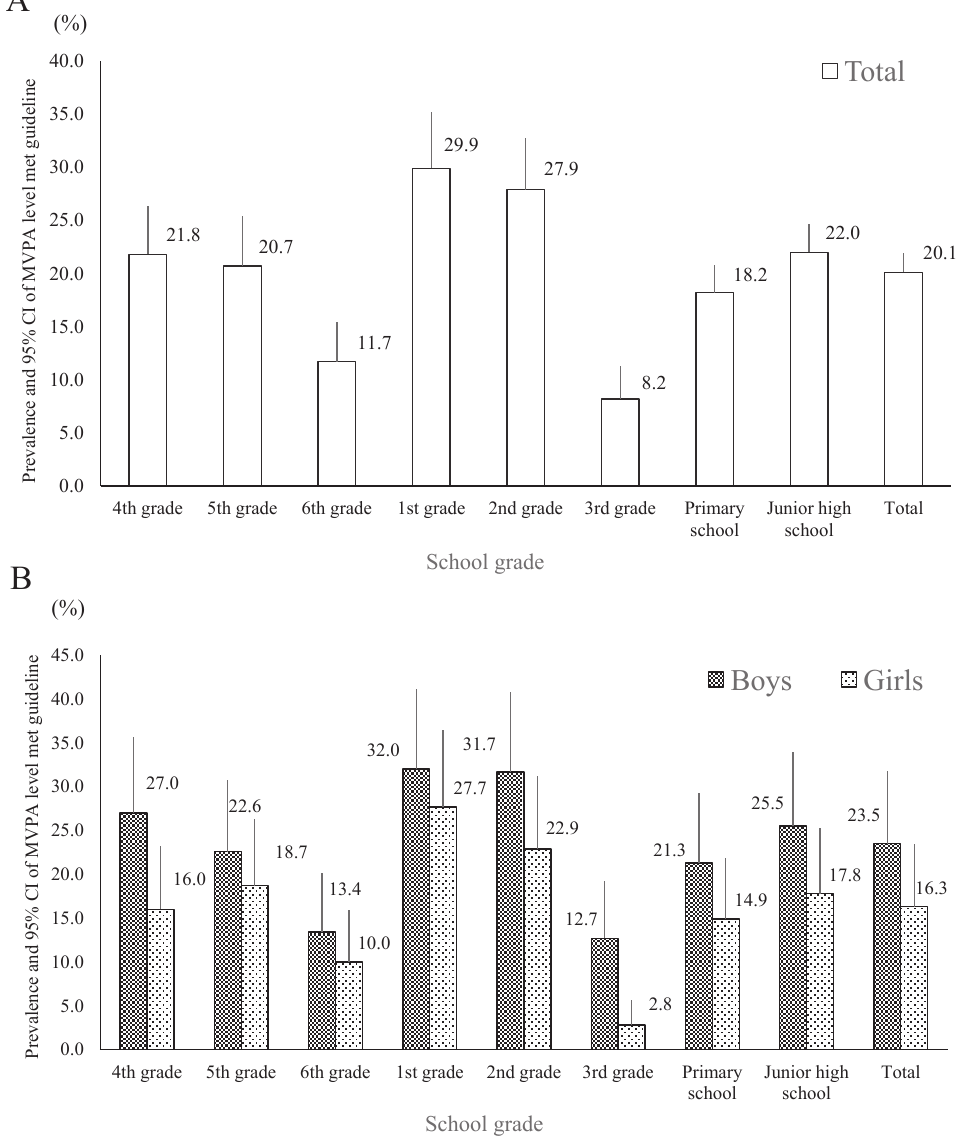
Figure 2. Prevalence and 95% con fi dence intervals (CIs) of engaging in recommended level of moderate-to-vigorous physical activity in the total (A) sample and di ff erences between boys and girls (B). Primary school grade is 4th grade (9 –